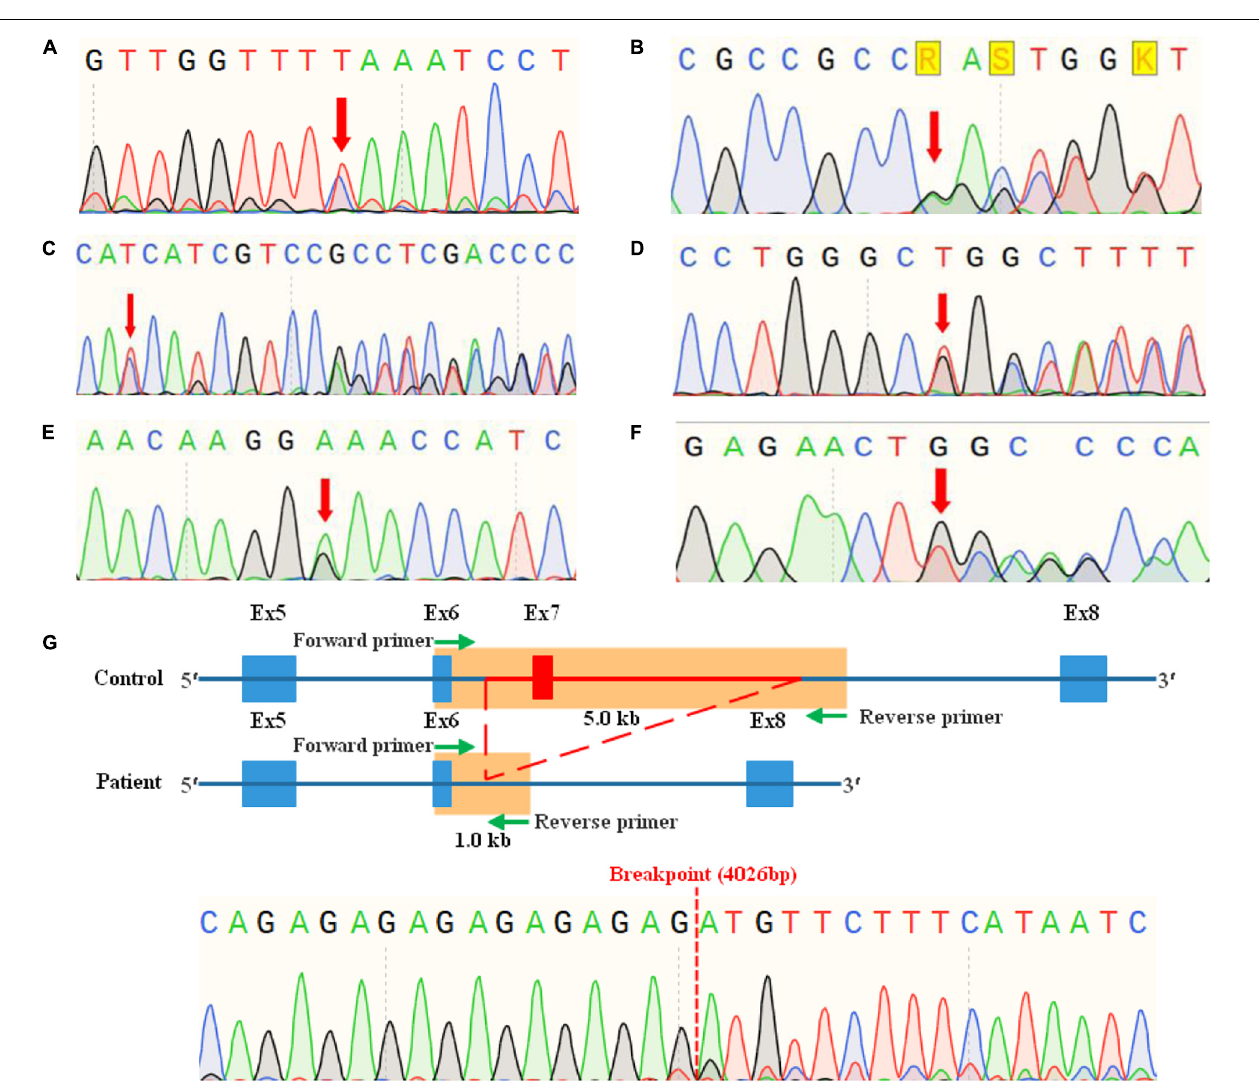
FIGURE 3 | Mutation analyses of Chinese Waardenburg syndrome families WS01 to WS07 by sanger sequencing. (A) Heterozygous mutation c.1459C > T of PAX3 in WS01-II:1. (B) Heterozygous mutation c.123del of PAX3 in WS02-I:1, II:3, III:1, and III:2. (C) Heterozygous mutation c.198_262del of SOX10 in WS03-I:2, II:1, and III:2. (D) Heterozygous mutation c.529_556del of SOX10 in WS04-II:1. (E) Heterozygous mutation c.731G > A of MITF in WS05-III:3, IV:4. (F) Heterozygous mutation c.970dup of MITF in WS06-II:1. (G) Heterozygous mutation c.959-409_1173+3402del of PAX3 in WS07-I:1, II:1.